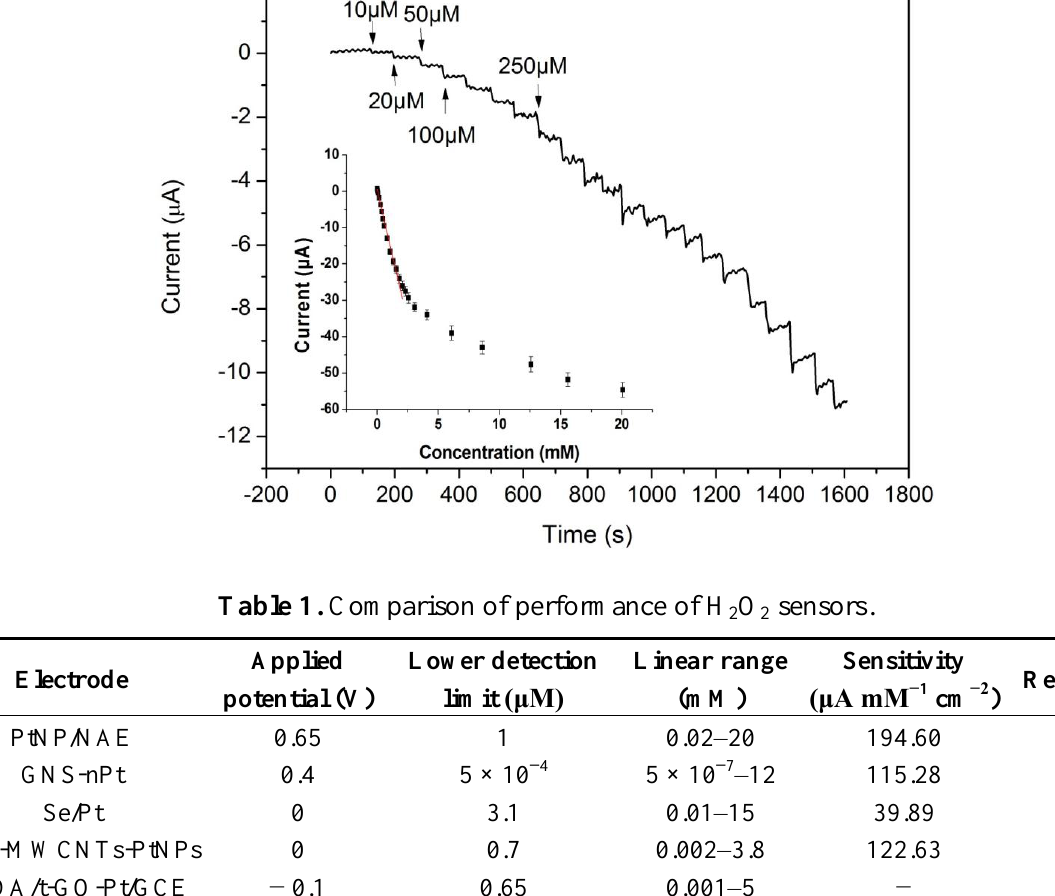
Figure 4. Amperometric responses of the MWCNTs/Pt NPs-modified Pt electrode upon successive addition of H O in 0.1 M PBS (pH 7.0). Applied potential: 0 mV. Inset: A 2 2 calibration curve.